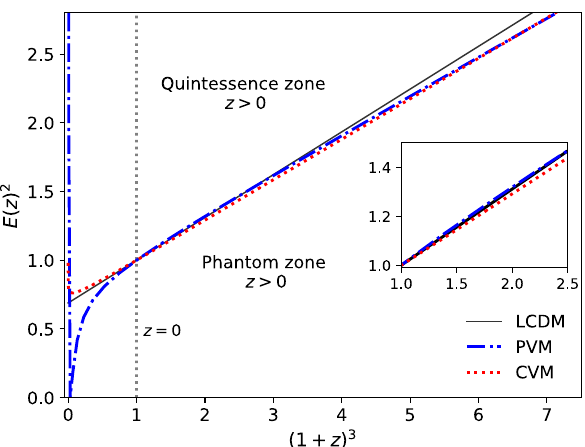
Fig. 5 Behavior of E ( z ) 2 over ( 1 + z ) 3 . Solid black line represents LCDM model, blue dot-dashed line is the PVM, and red dotted line is the CVM. For the PVM, we observe a slightly transition from phantom to quintessence behaviour in the region 1 < z < 2 . 5. Vertical dotted line represents the current Universe ( z =